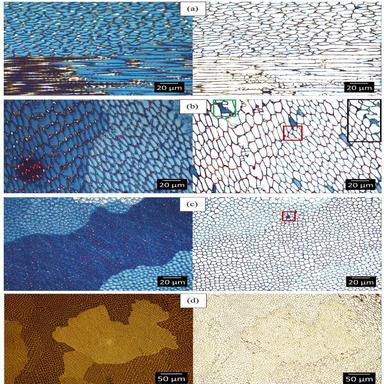
Prediction results of regional instance segmentation approach. Left side images are test images and right side images are their predictions. Feature size relative to image dimension decreases from image (a) to (d).